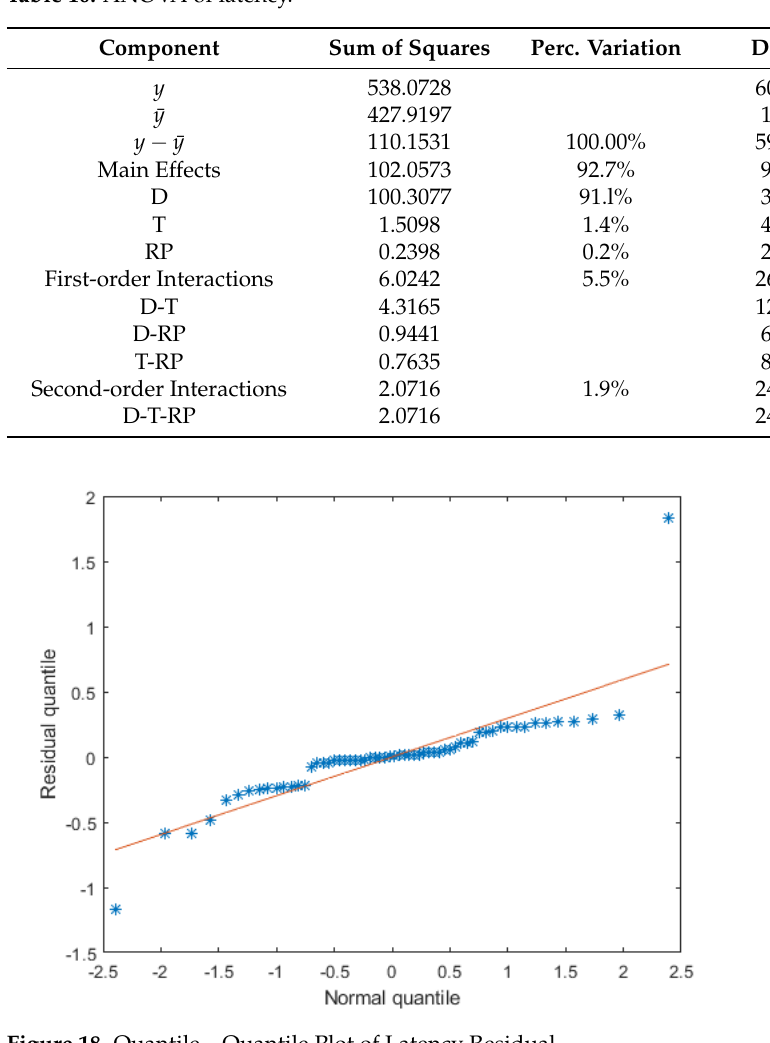
Figure 18. Quantile—Quantile Plot of Latency